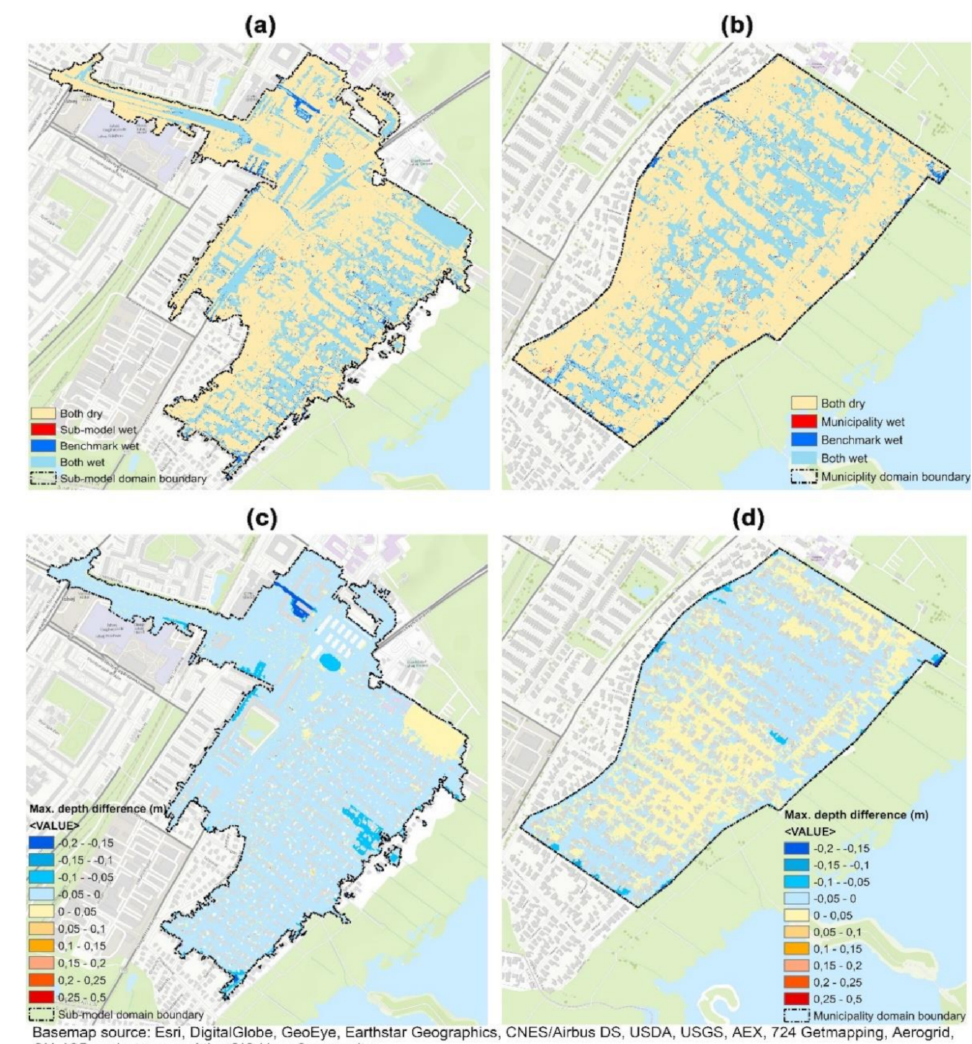
Figure A1. Maximum depth flood extents and maximum depth differences with the uniform open- boundary condition: ( a ) Sub-model approach’s categorised map, ( b ) Municipality domain approach’s categorised map, ( c ) Sub-model approach’s depth difference map, ( d ) Municipality domain ap- proach’s depth difference